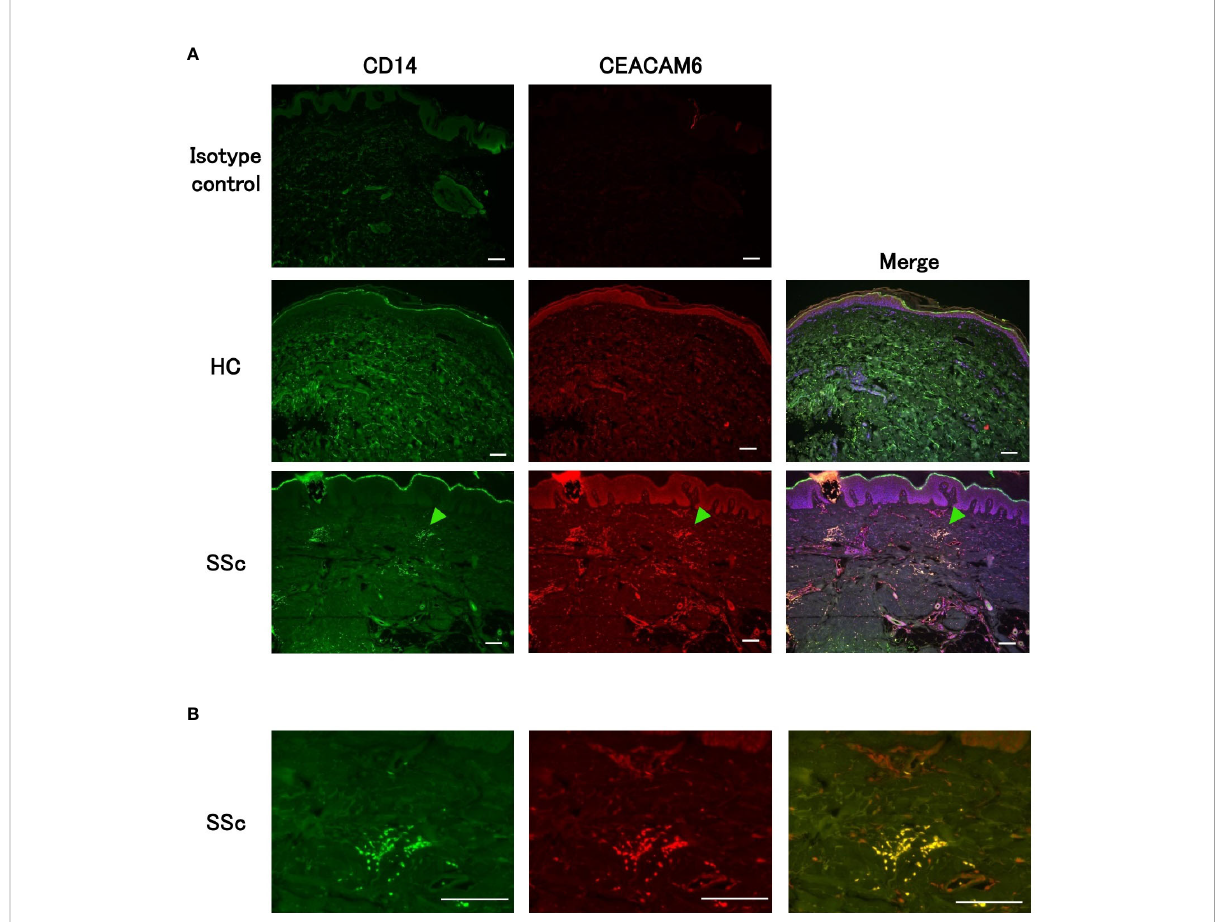
FIGURE 6 CEACAM6+CD14+ monocytes in fi ltrate scleroderma skin. (A) Representative immuno fl uorescence of dermal tissues from patients with SSc (n=5) and HCs (n=2). Sections were stained with CD14 (green), CEACAM6 (red), and DAPI (blue). The green arrowhead shows the accumulation of CEACAM6+CD14+ monocytes in the dermis. Sections stained with IgG isotype control for anti-CD14 and anti-CEACAM6 antibodies and detected with corresponding secondary antibodies are also shown as isotype control. (B) Magni fi cation images of the arrowhead of part (A) . Scale bar represents 100 m